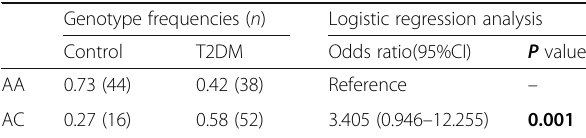
Table 2 Association analysis of BMP15 genotype for T2DM and control Table 3 Association analysis of